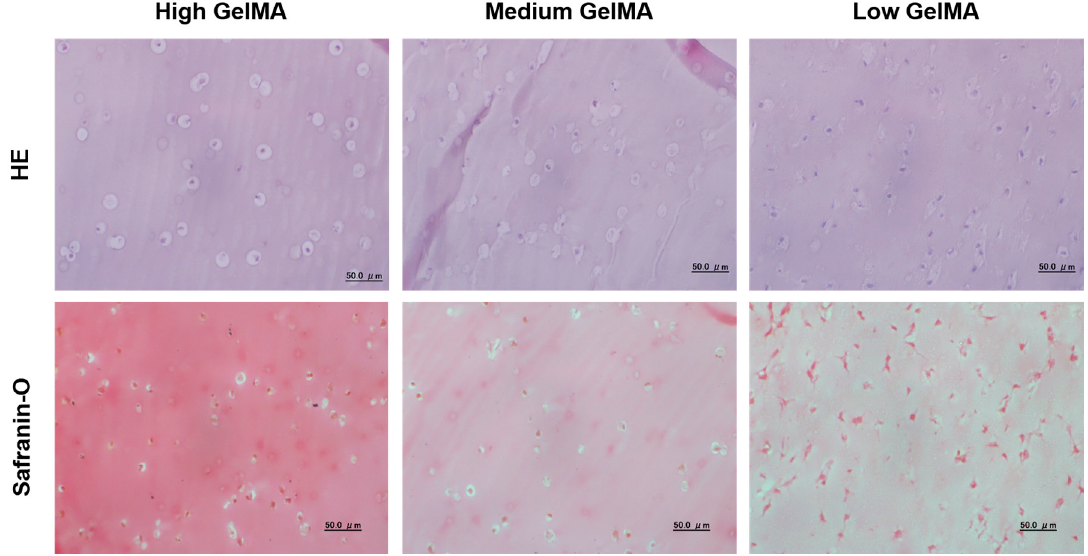
Figure 7. HE and safranin-O stainings of chondrocytes cultured in the GelMA hydrogels for 14 days.